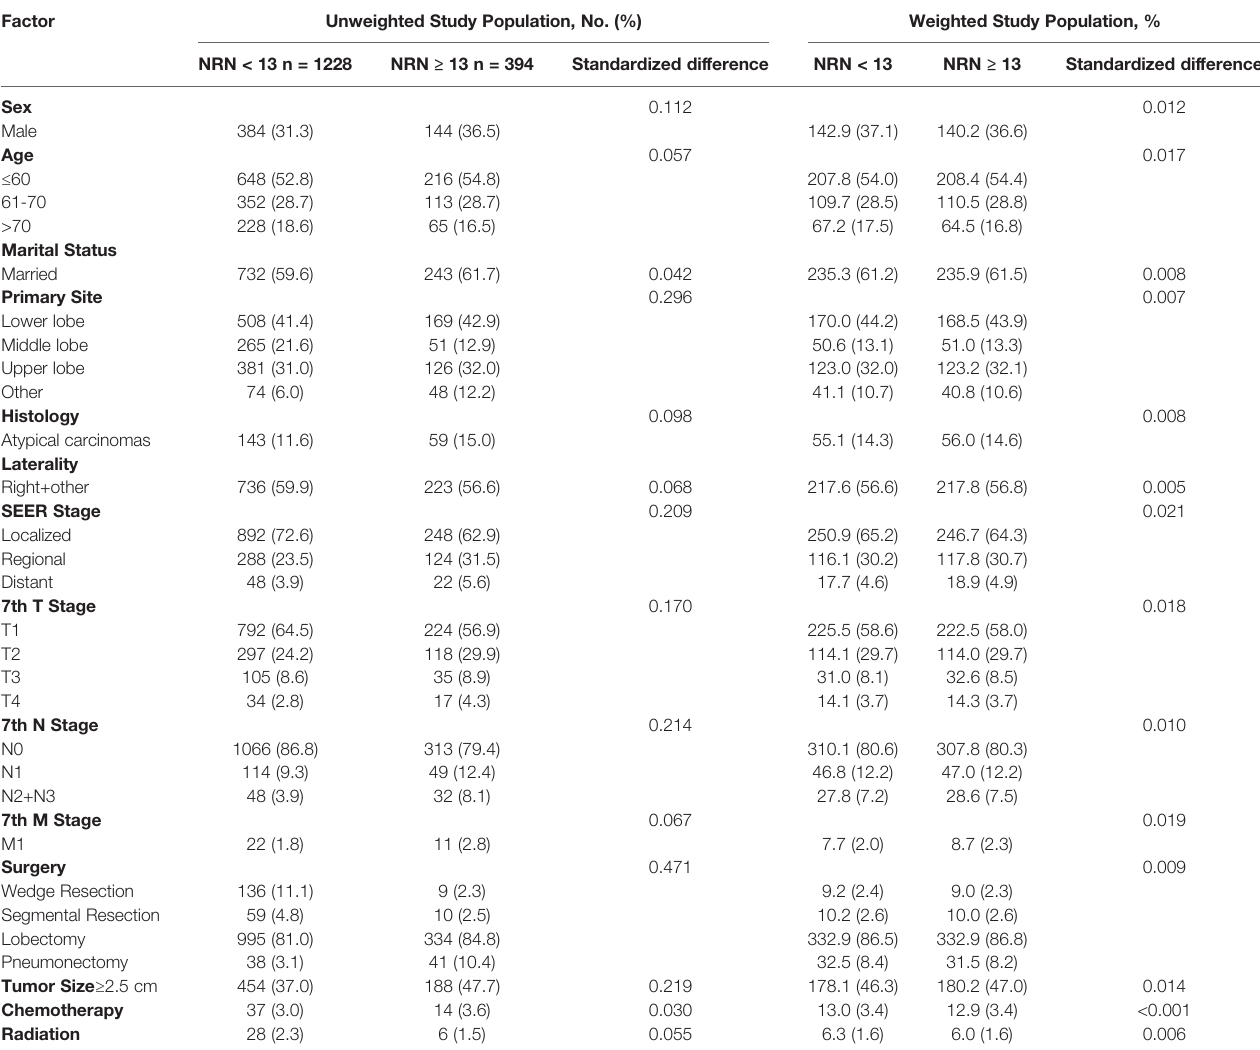
TABLE 2 | Selected baseline characteristics between NRN<13 and NRN ≥ 13 before and after weighting. Factor Unweighted Study Population, No. (%) Weighted Study Population, %